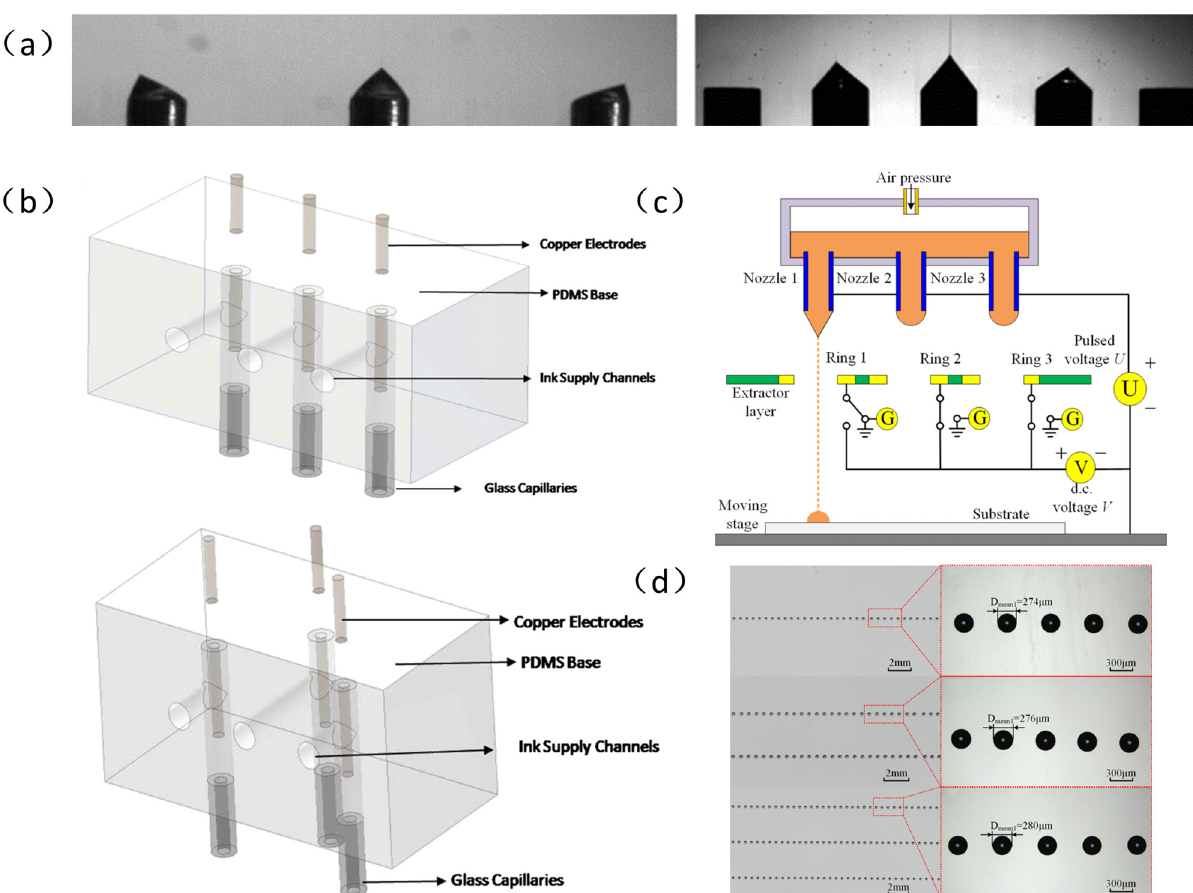
Figure 8: ( a ) End e ff ect diagram. Reproduced from ref. [ 111 ] with permission from Elsevier. ( b ) Schematic diagram of linear and triangular array multinozzle print heads. Reproduced from ref. [ 114 ] with permission from Elsevier. ( c ) Schematic diagram of addressable E - jet printing with multilevel voltage parallel nozzles. ( d ) The array of droplets obtained by printing with one, two, and three nozzles. Reproduced from ref. [ 116 ] with permission from American Institute of